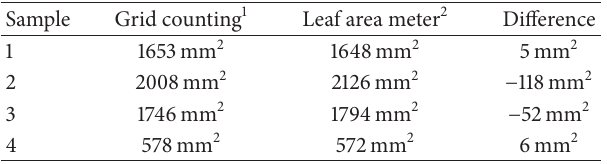
Table 3: Comparing grid counting method with developed leaf area